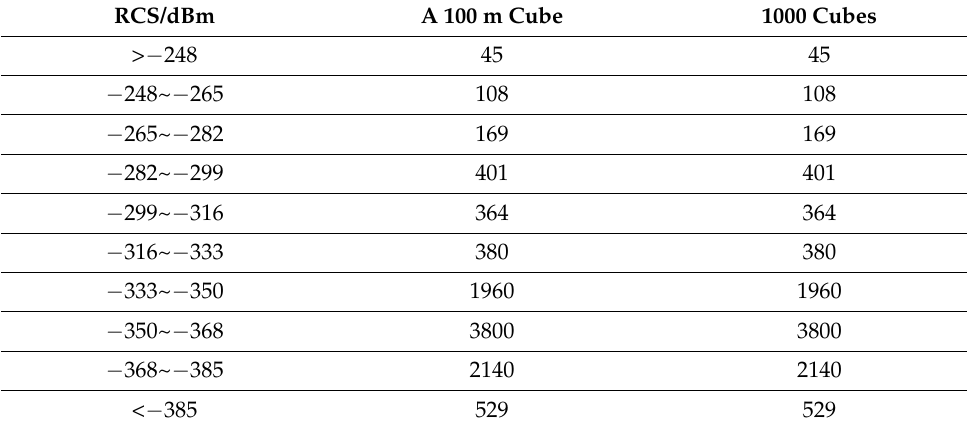
Table 2. The comparison between single cube and cube